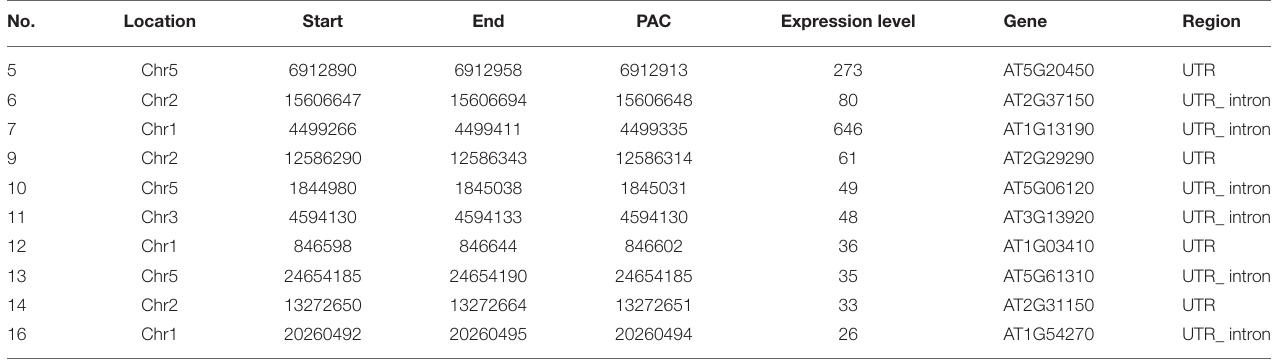
TABLE 2 | PAC sites in the 5 ′ -UTR confirmed by 3 ′ -RACE followed by sequencing. No.